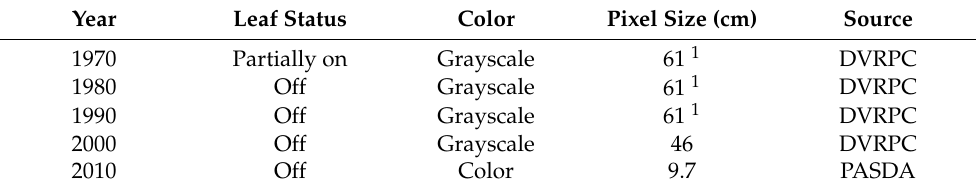
Table 1. Aerial photos used to assess land cover. Images were obtained from the Pennsylvania Spatial Data Clearinghouse (PASDA) and the Delaware Valley Regional Planning Commission